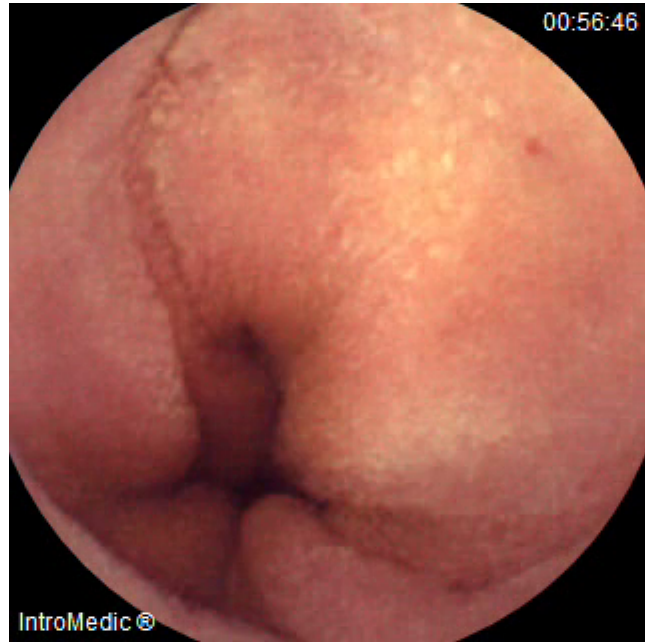
Figure 1. KID video 1 frame.